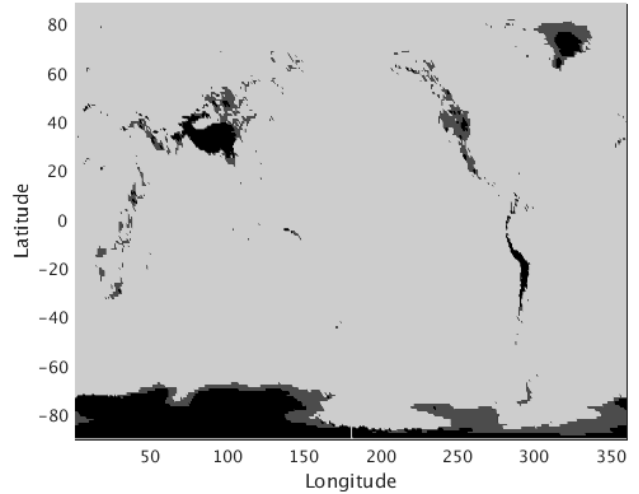
Figure 2. Surface elevation groups. The grayscale assignments are light gray for Ps ≥ 850 hPa, dark gray for 700 hPa ≤ Ps < 850 hPa, and black for Ps < 700 hPa.